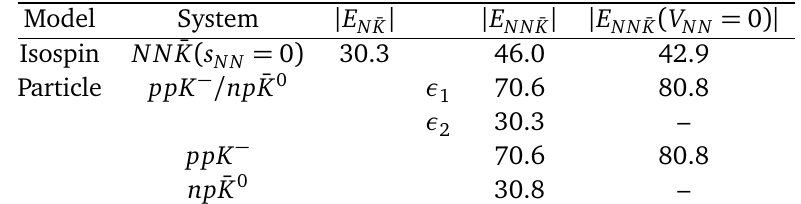
| of the " ppK − " cluster calculated within Table 1: The quasi-bound state energy | E NN ¯ K the isospin formalism and particle model with the AY ¯ KN and MT I-III nucleon- | is the binding energy of the pair N ¯ K ( pK − or n ¯ K 0 ). The nucleon potentials. | E N ¯ K energies of the separated ppK − and np ¯ K 0 systems are presented. The values of | E ( V = 0 ) | when the interaction between two nucleons is turned off are shown. NN NN ¯ K ε and ε are the lower and upper energies of the quasi-doublet state ppK − / np ¯ K 0 , 1 2 respectively. The energies are given in MeV. The masses of the kaons (nucleons) are equal to the value for averaged mass.